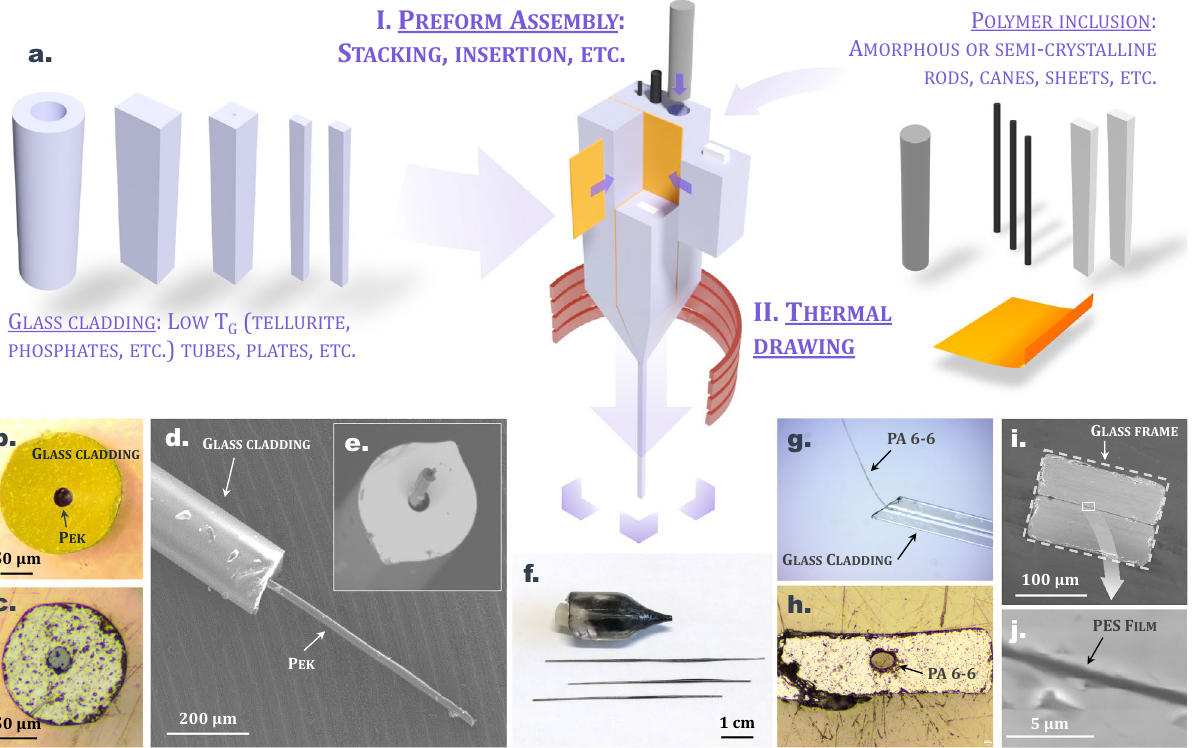
Figure 3. ( a ) Description of the molten core method applied to glass-polymer associations (image created using blender software version 2.92.0, www. blend er. org/). Cross-sectional view of ( b ) a TZL65 glass cladding / PEK core fiber and a ( c ) TZL65 glass cladding / PEEK core fiber. ( d ) and ( e ) SEM images of a TZL65 glass cladding / PEK core fiber with the thin PEK core poking out of the glass cladding. ( f ) Picture of the neckdown region and canes from the failed stretching of a TZN60/PLA composite preform. ( g ) Longitudinal and ( h ) cross-sectional view of a rectangular TZN60 glass fiber with a central continuous Nylon inclusion. ( i ) and ( j ) SEM images (× 300 and × 10,000 respectively) of a TZN75 glass fiber integrating a thin PES structure. within larger glass structures. Information about the different glass/polymer combinations that are tested is summarized in Table 2. Figure 3b,c show a TZL65 glass fiber (glass compositions 65 TeO 2 –30 ZnO–5 La 2 O 3 mol %) with PEK and PEEK cores respectively. Remarkably, the continuous organic inclusion runs all along the fiber length, as illus- trated on Fig. 3d,e, where a thin continuous PEK filament is seen pocking out of a larger glass cladding. A similar successful integration of a Nylon wire within a rectangular TZN60 glass cladding (glass compositions 60 TeO 2 –20 ZnO–20 Na 2 O mol %) is depicted on Fig. 3g,h. The co-drawing of the selected materials is possible because, as discussed in the previous section, the drawing temperature of the cladding glass lies between the melting and decomposition temperatures of the considered semi-crystalline polymers. When this criterion is not respected, the organic structure risks severe degradation, as seen in Fig. 3f, which describes the neckdown region and canes resulting from the thermal stretching of a PLA rod (8 mm in diameter) within a TZN60 glass tube. The drawing temperature range of the vitreous cladding material exceeds the decomposition temperature of PLA (350–370 °C against 309 °C respectively), which leads to the deterioration of the thermoplastic that turns out completely carbonized after the drawing process. Indeed, those two materials do not appear compatible for the MCM from the diagram given in Fig. 2.